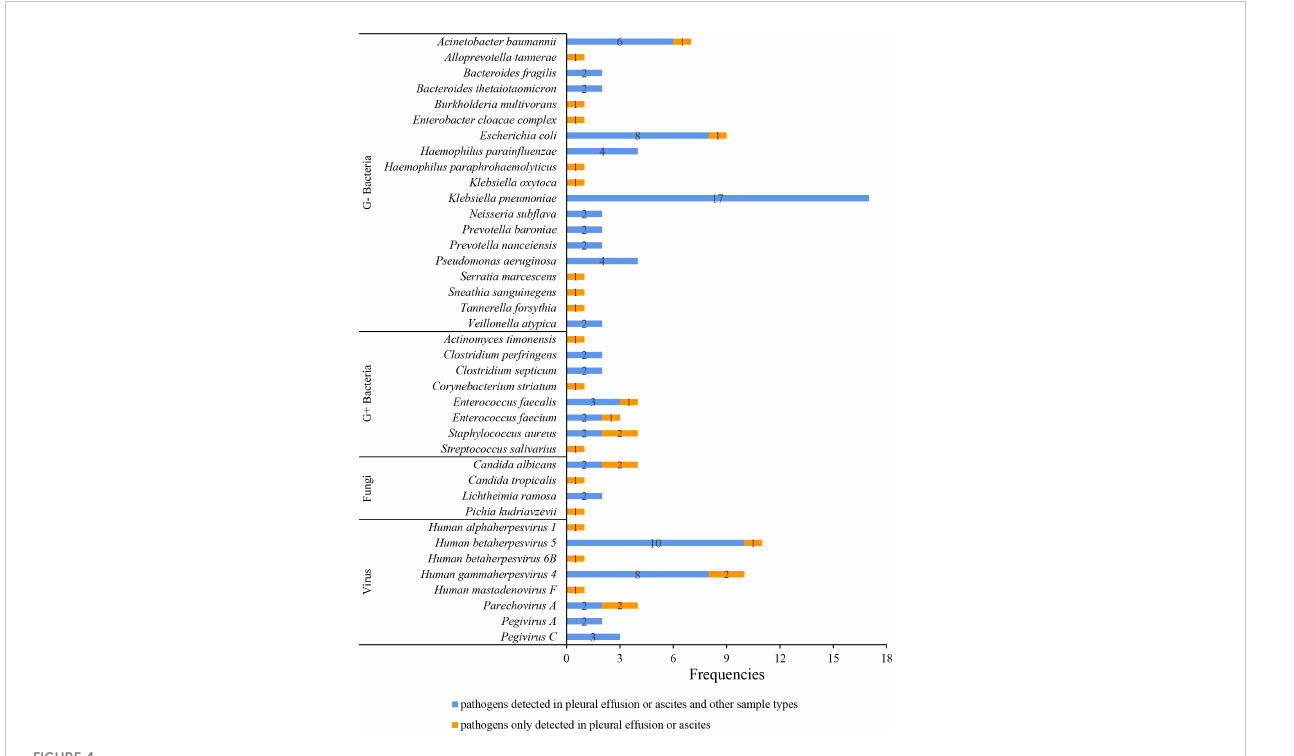
TABLE 2 Comparison of clinical features and pathogen constitution between the pathogen-consistent group and pathogen-inconsistent group.